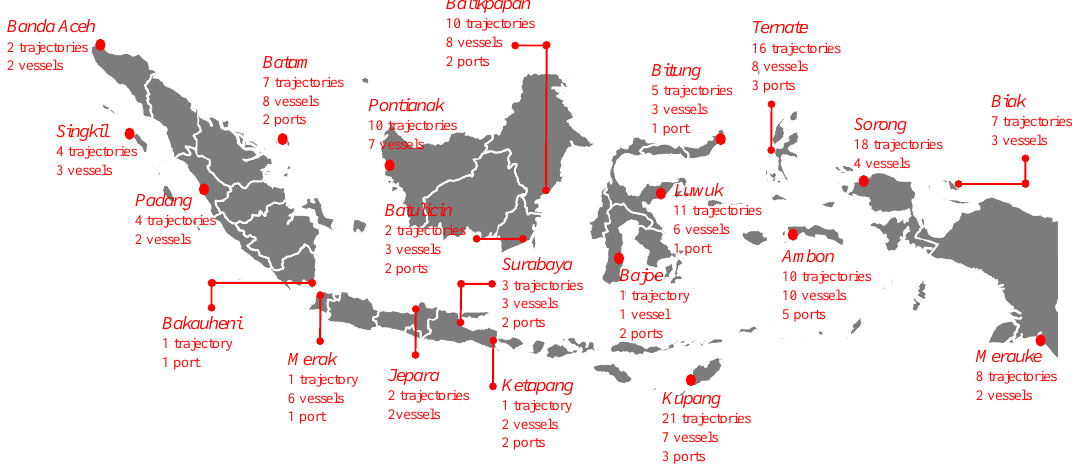
Figure 1. Location of port infrastructure across Indonesia territory (based on information in Ref. [4]).